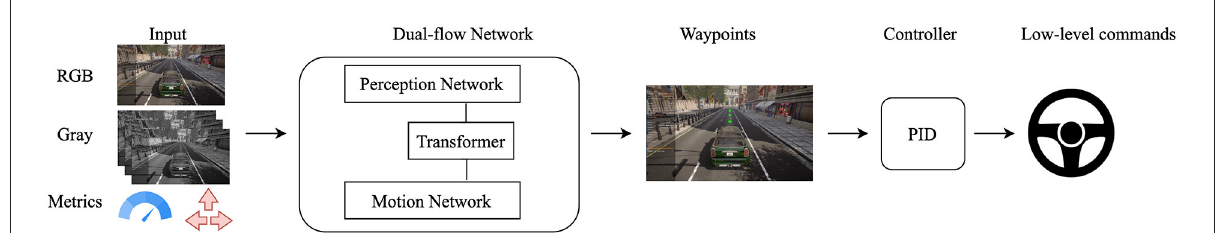
FIGURE1 Overview of the structure, including the video from the camera, vehicle speed, and high-level navigation commands as input, using a dual-flow network to extract features and output the prediction of waypoints, which are converted to the vehicle’s low-level commands through the proportional-integral-derivative (PID)